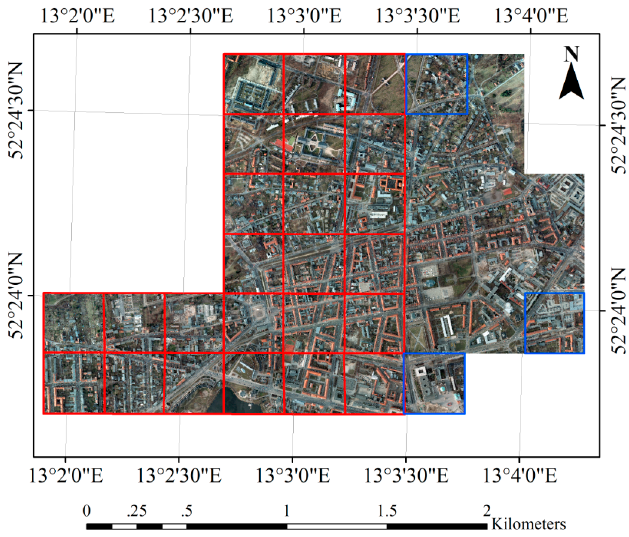
Figure 1. The true color composite image is shown for the Potsdam dataset, where the scenes marked in red are used for the training of the convolutional neural network, and the ones marked in blue are used for validation.